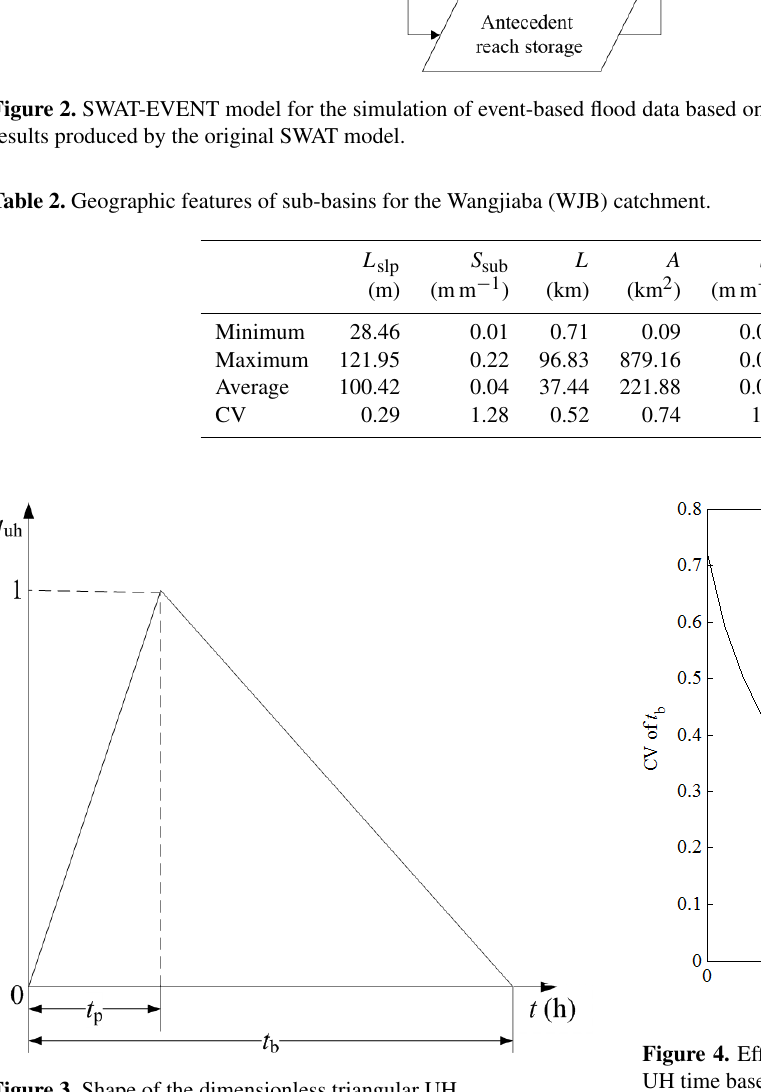
Figure 3. Shape of the dimensionless triangular UH.